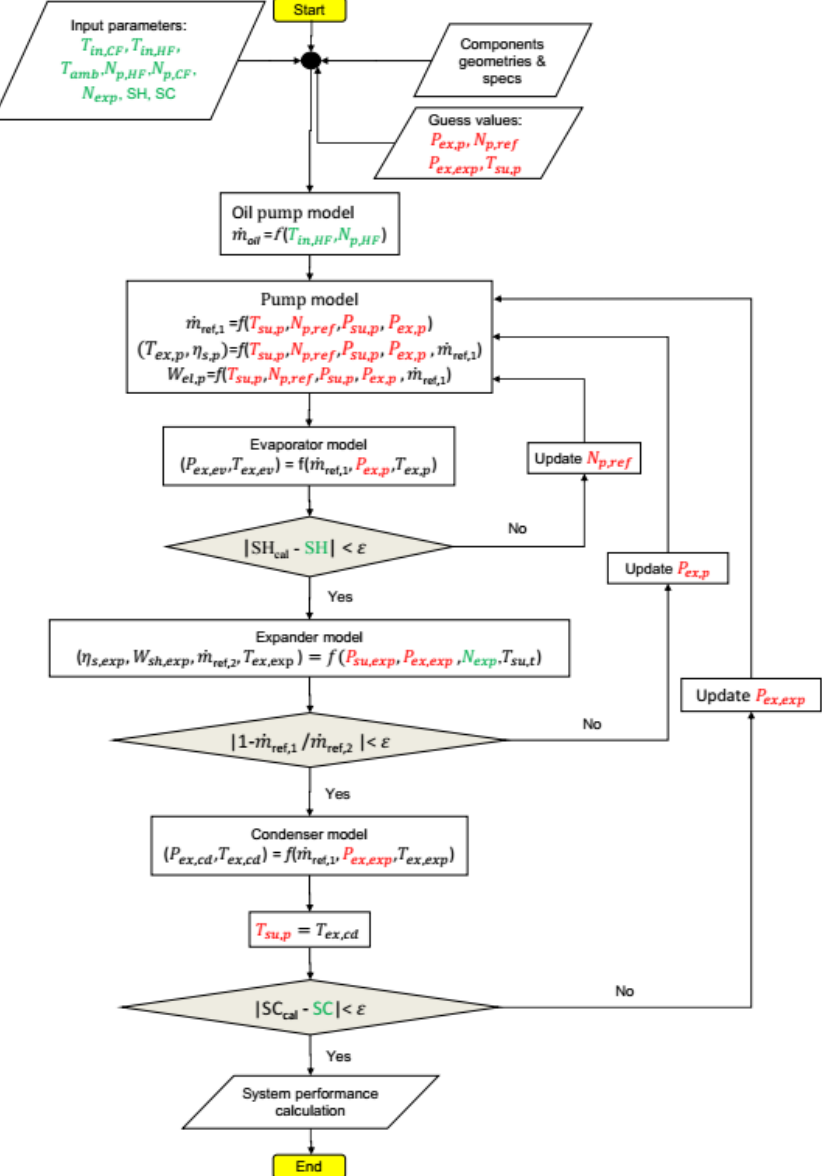
Figure 23. Flow chart of the object-oriented solver of the ORC system. The system performances were mapped in terms of net electric power and efficiency 24. The range of the variable parameters was kept as in the experimental data to avoid